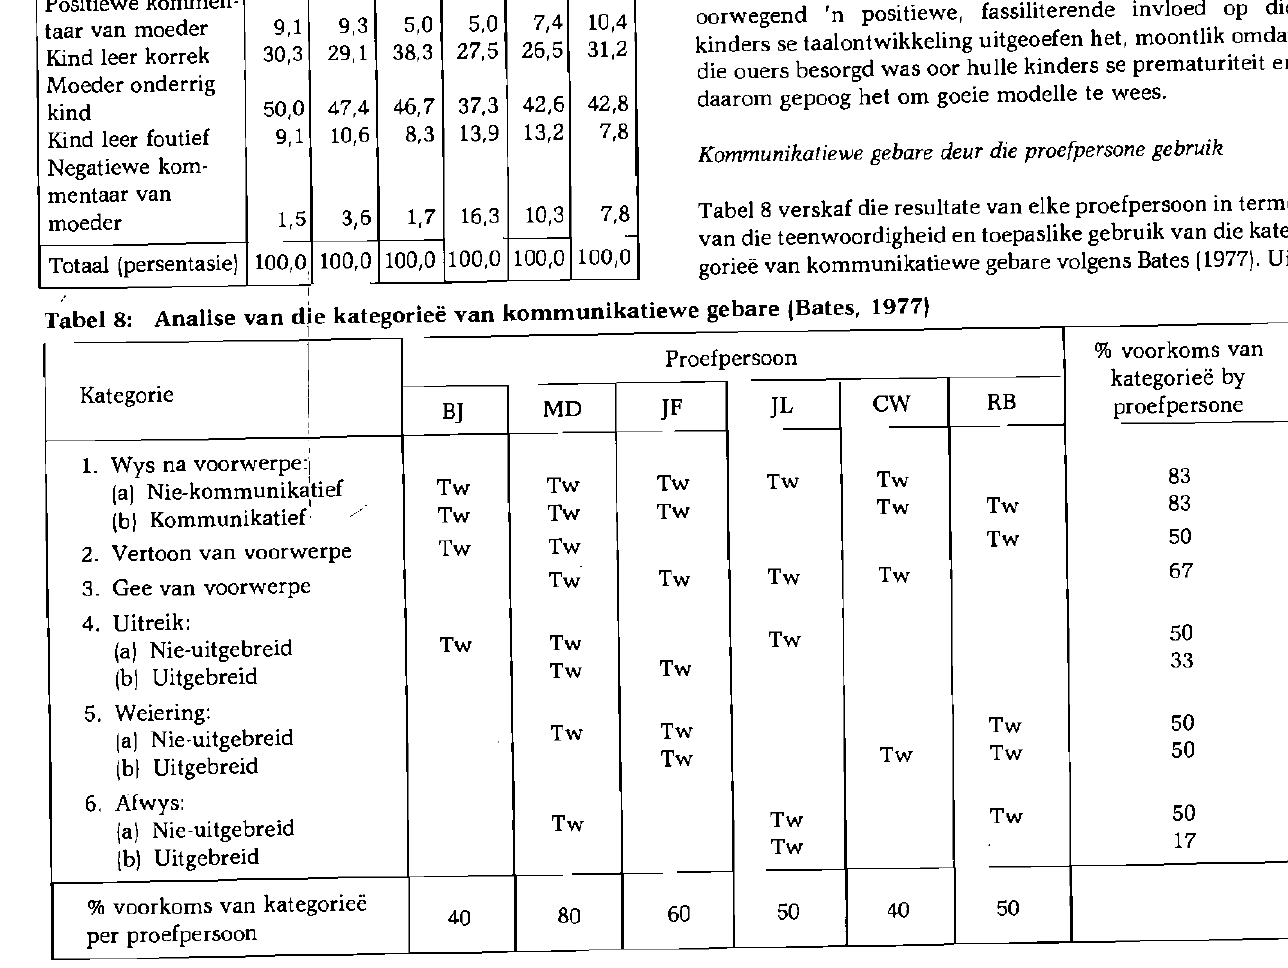
Tabel 8: Analise van die kategoriee van kommunikatiewe gebare (Bates, 1977)